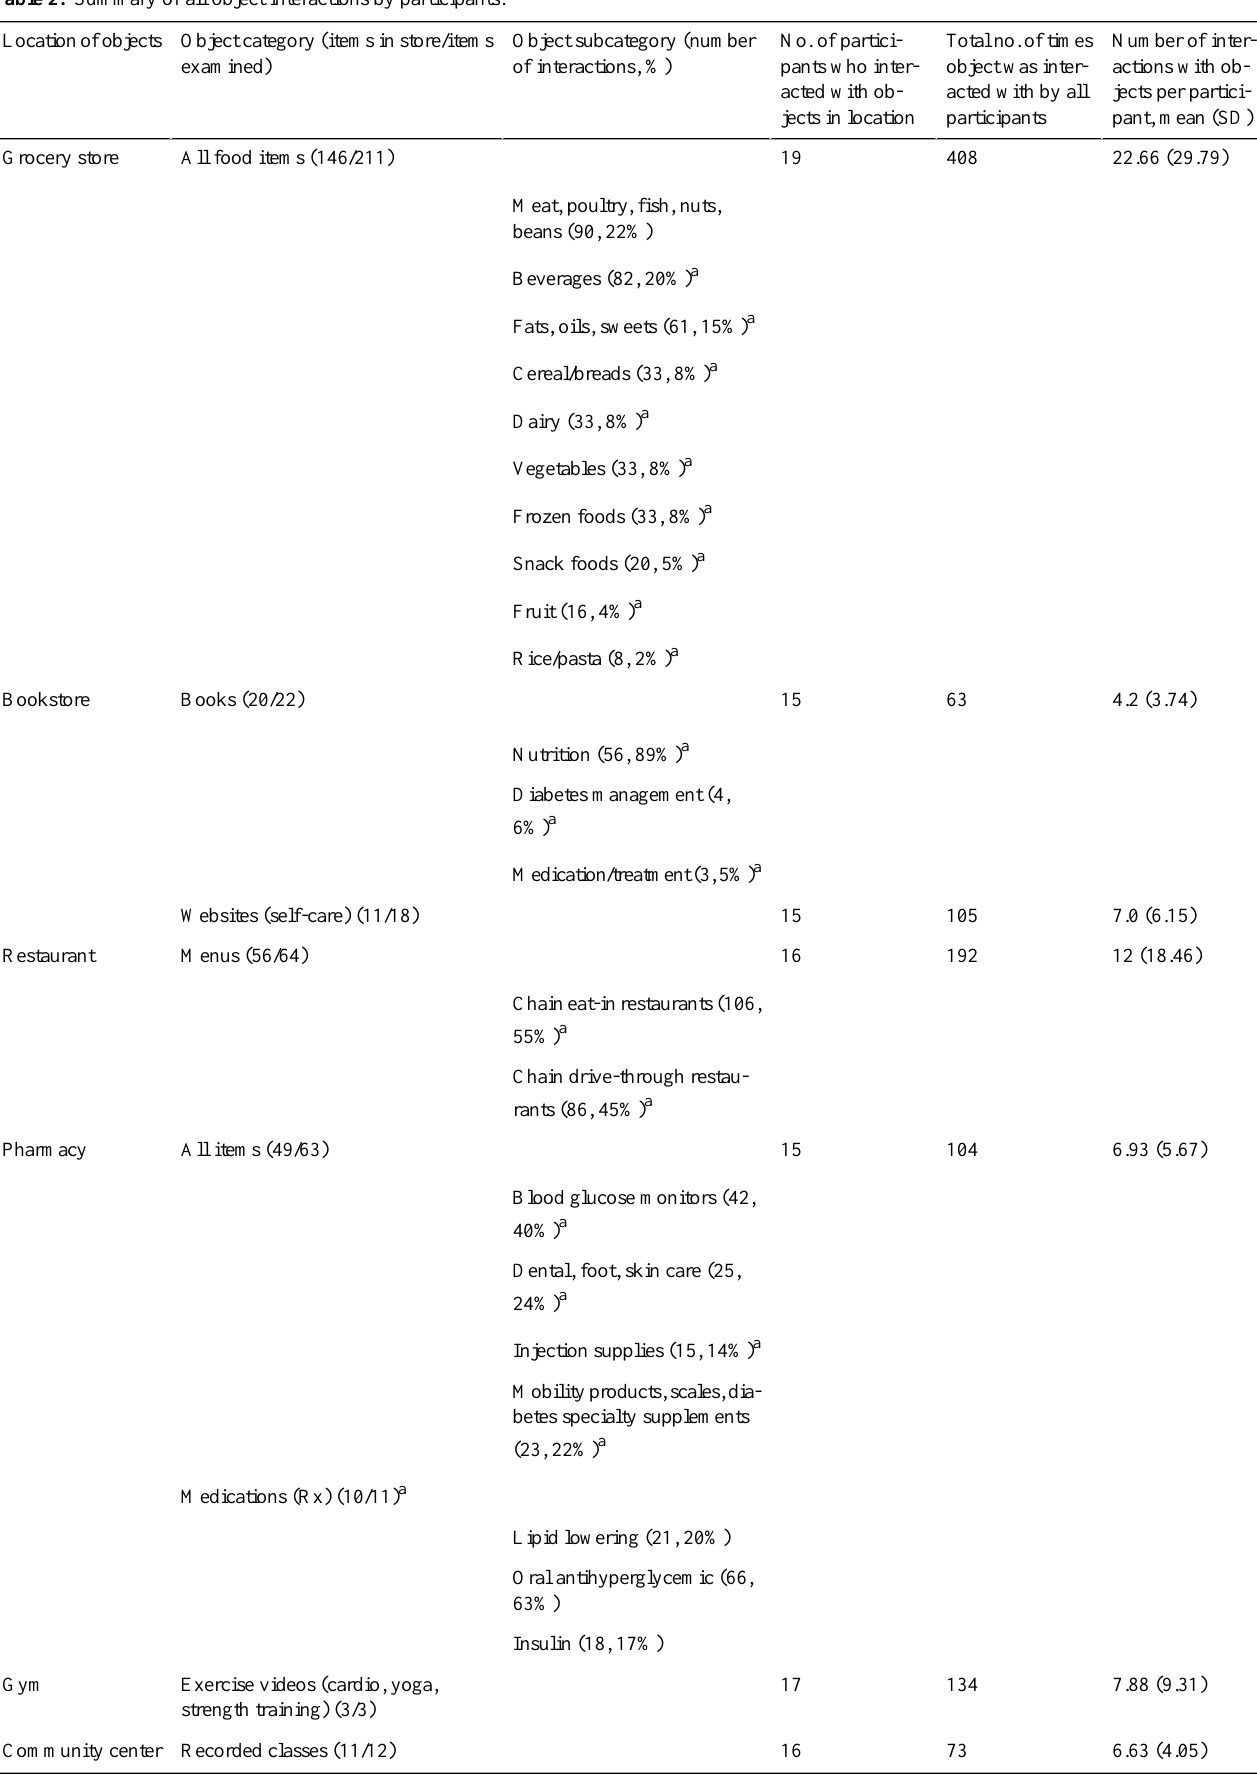
Table 2. Summary of all object interactions by participants.